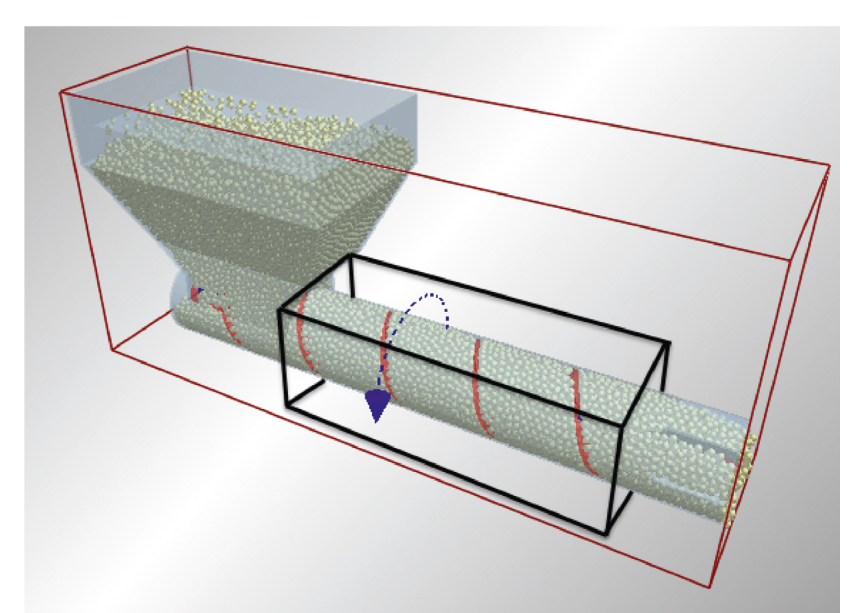
Figure 3: The simulation images of single-flight screw feeder.